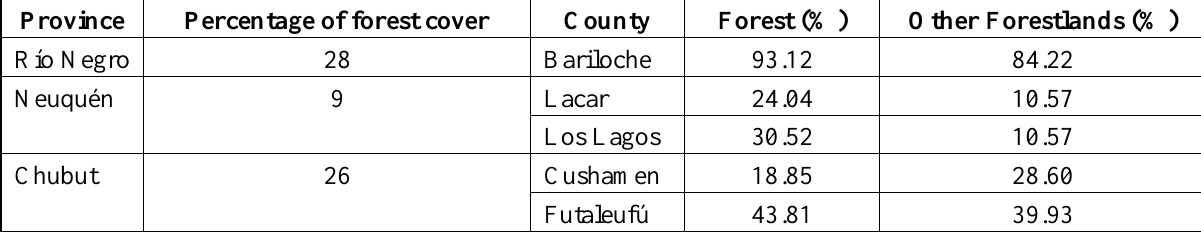
Table 6. Surface (%) of native forests and other forestlands with respect to the total area of the province.